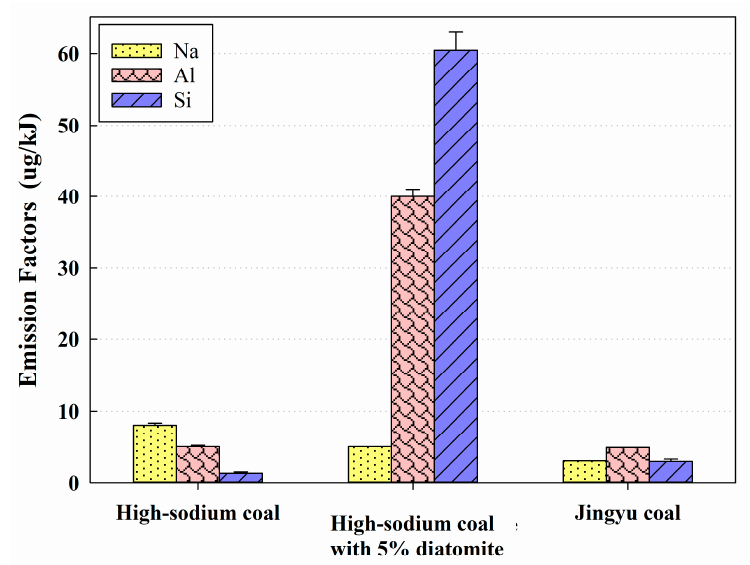
Figure 5. EFs of Na, Al and Si in PM 2.5 for different coal samples.